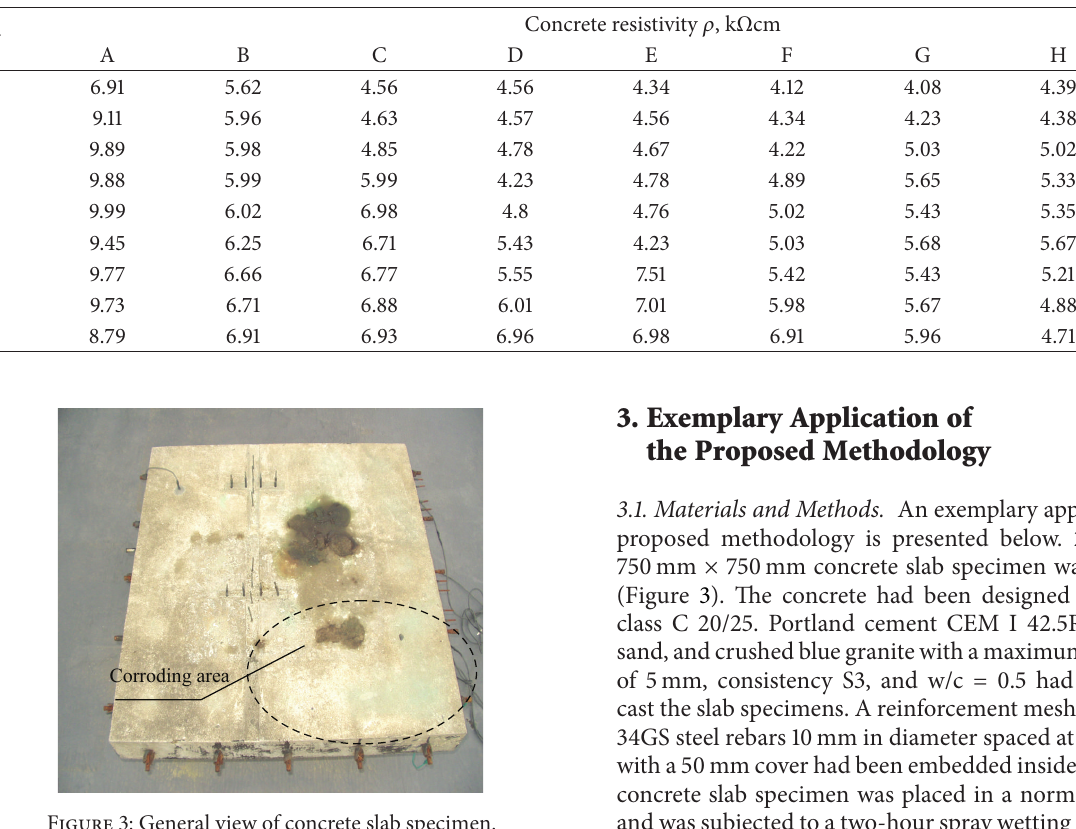
Table 4: Concrete resistivity 𝜌 .